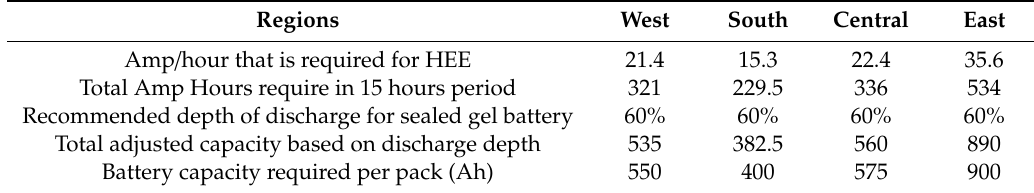
Table 10. The battery bank calculation for the KSA in di ff erent